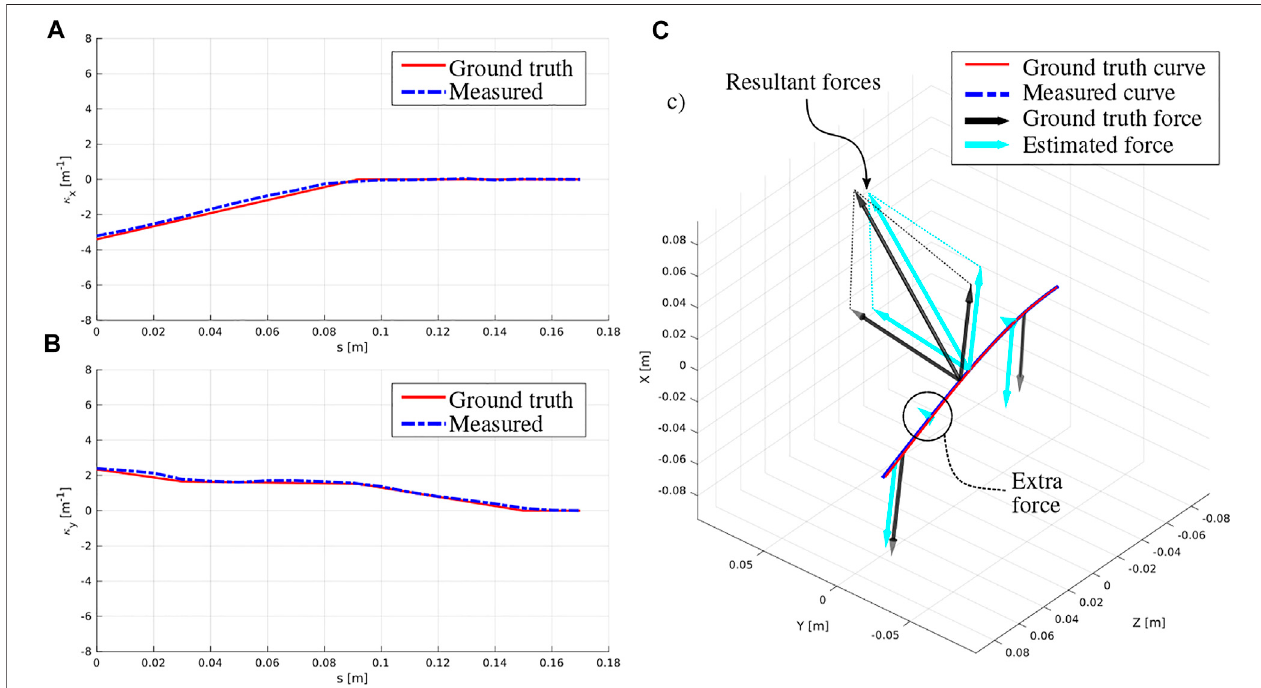
FIGURE5 | Exampleresult forthe case where three externalpoint forces are applied onto the rod. (A) pro fi le ofthe x- component ofthe curvature, (B) pro fi le of the y- component of the curvature, (C) deformed rod showing a comparison between the ground truth and estimated shape and applied forces.